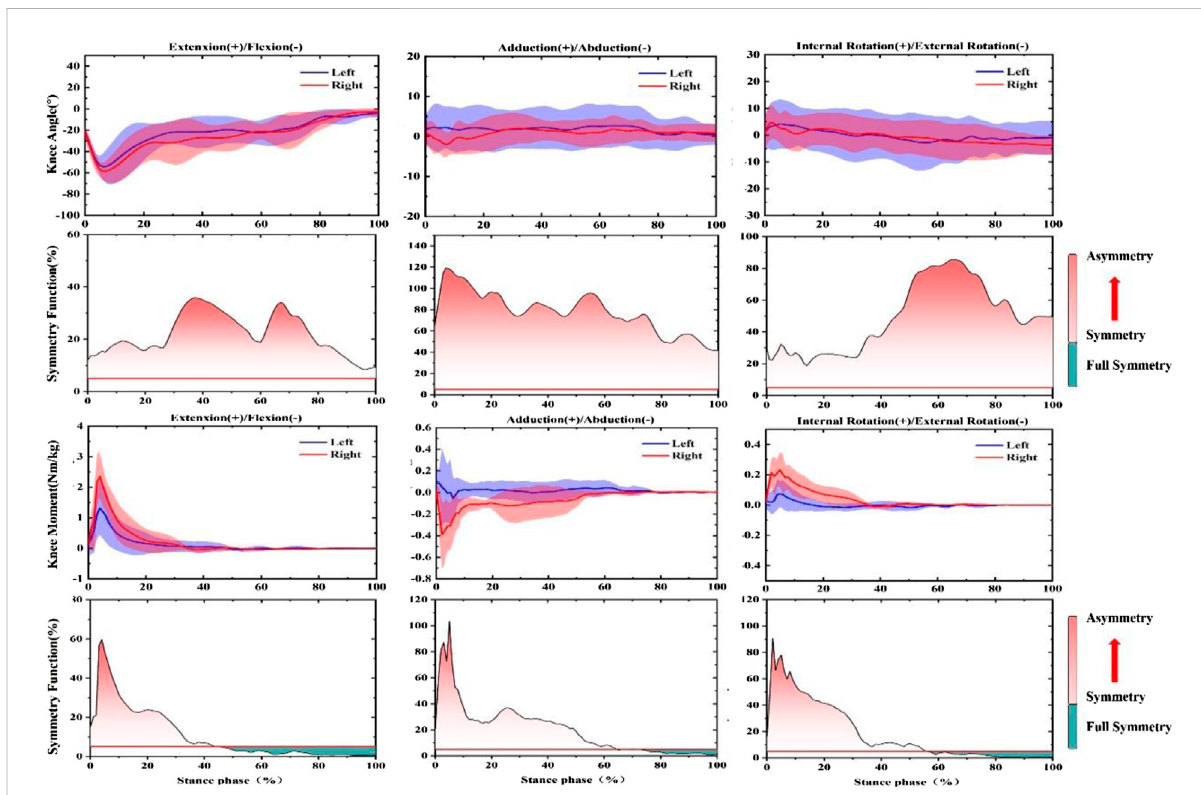
FIGURE 3 IllustrationofSFdegreeinbilateralkneejointangleandmomentduringthelandingphasebeforeprolonged-runningprotocolfortheCMJtest. Note: The red fi ll represents the degree of asymmetry, and the darker the color, the more asymmetry. The green fi ll represents full